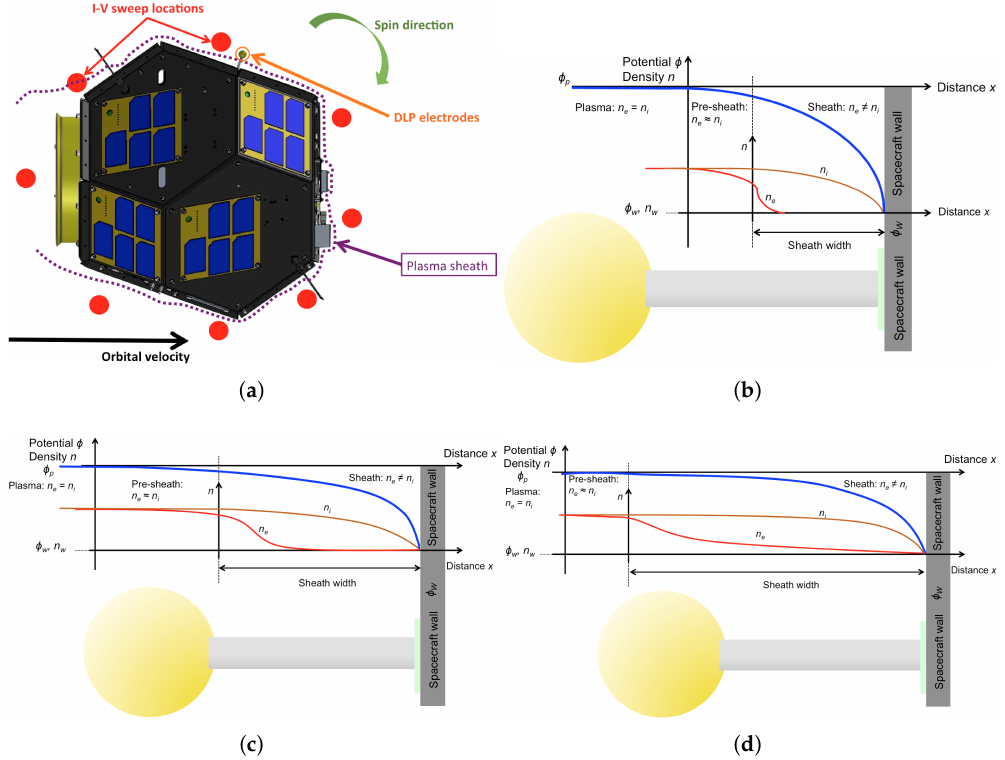
Figure 4. Representation of the DLP measuring system: ( a ) I–V (current–voltage) sweep locations around a spinning spacecraft; and ( b – d ) 1-D model representing the electrodes inside and outside of the plasma